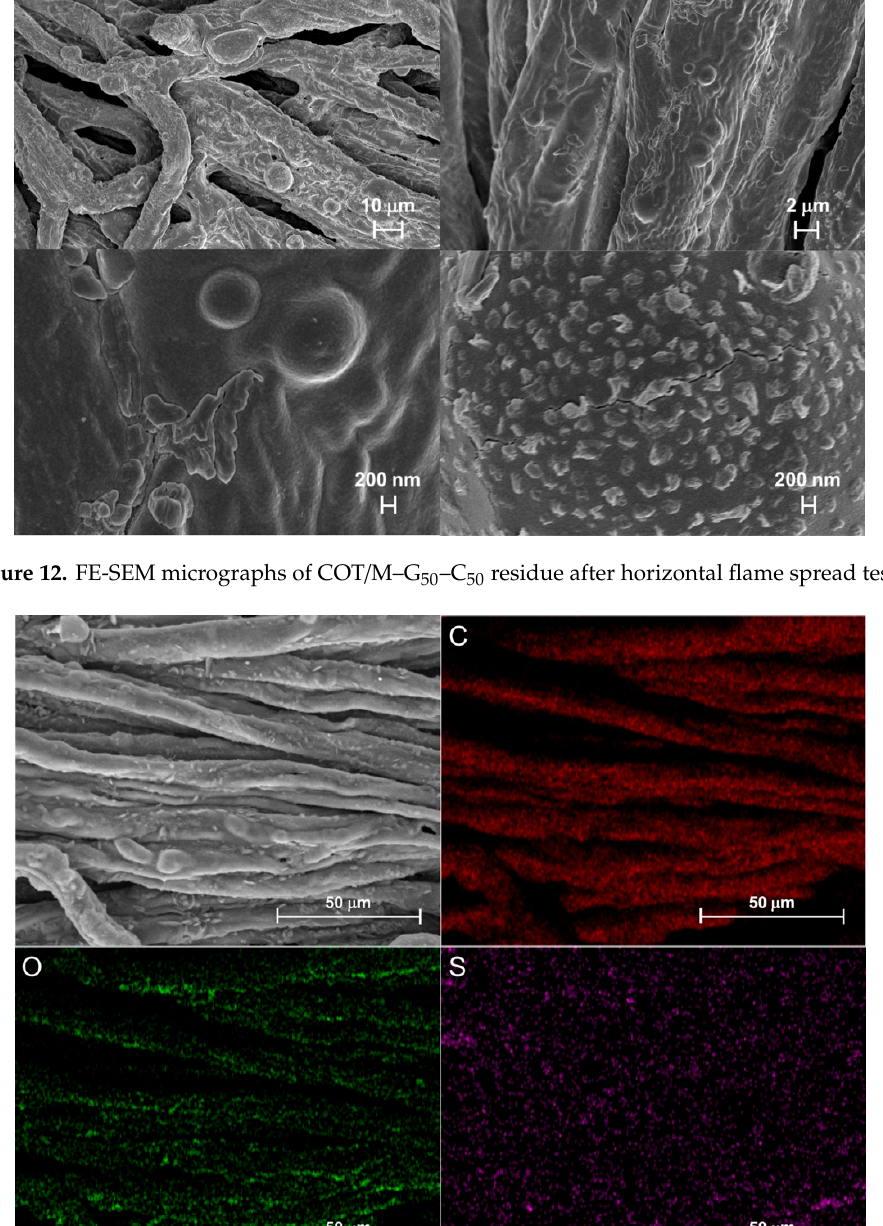
Figure 13. EDX analysis of COT/M–G 50 –C 50 residue after horizontal flame spread tests. Distribution of carbon (C), oxygen (O), and sulfur (S).